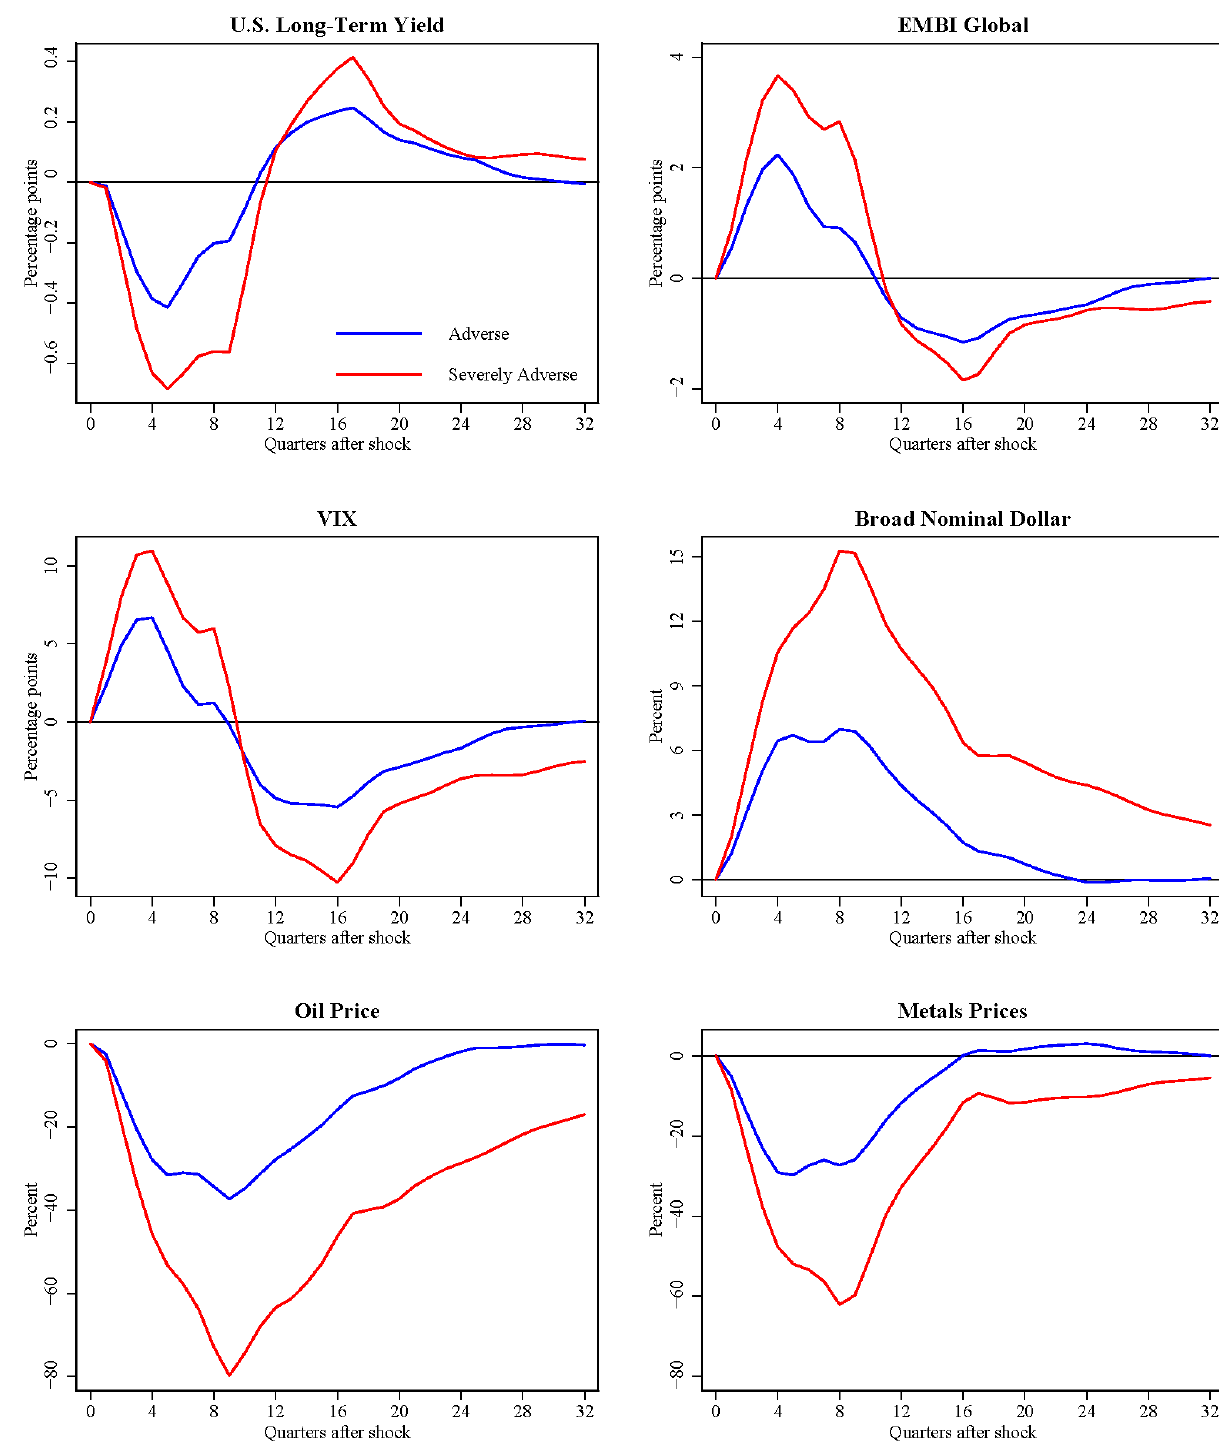
Figure 8. Financial responses to China GDP scenarios. Source: authors’ calculations using data from Haver Analytics and Bloomberg.